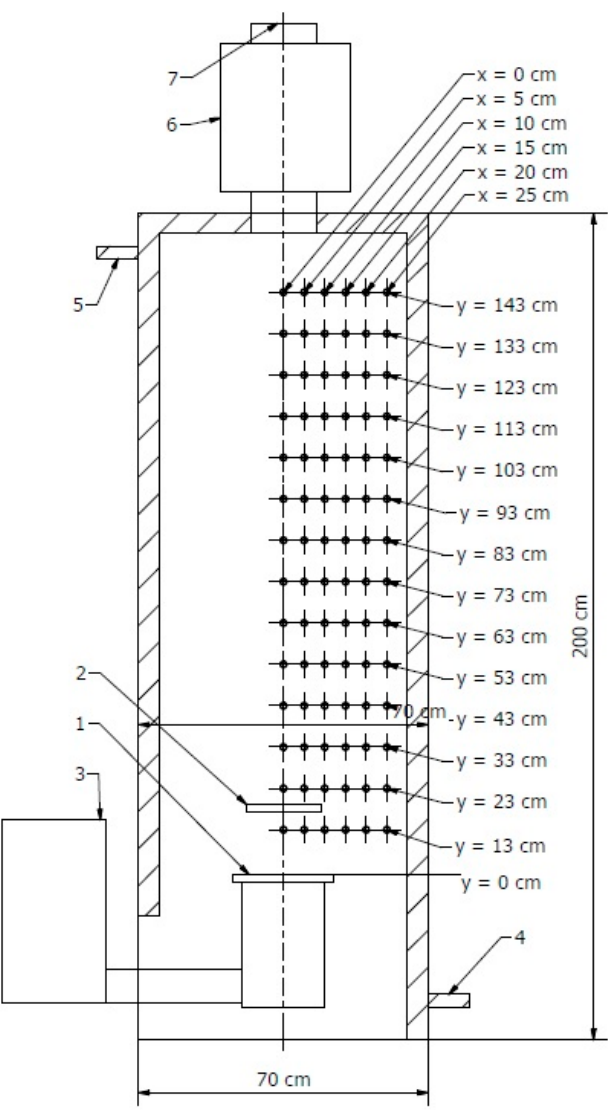
Figure 1. Scheme of a cylindrical chamber with marked measurement points used during the experiment, 1—retort feeder, 2—deflector, 3—fuel tray, 4—water inlet, 5—water outlet, 6—insulated measurement duct, 7—flue gas outlet to the chimney.